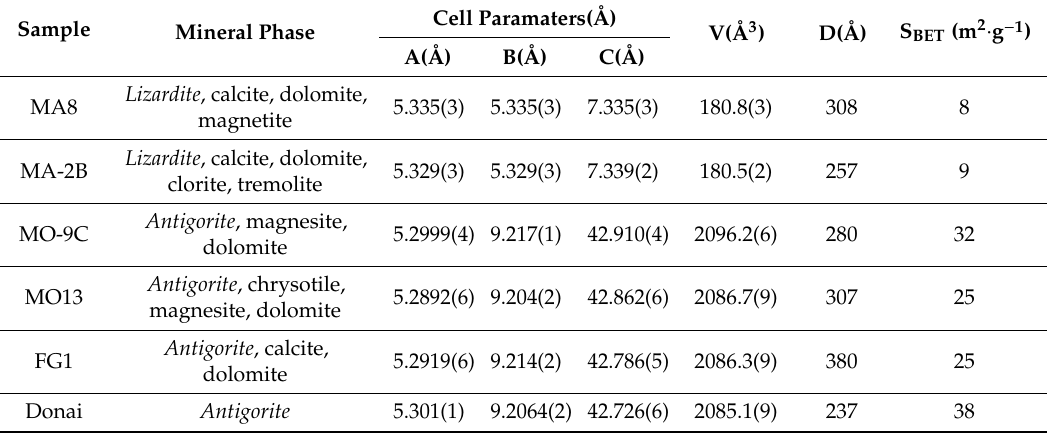
Figure 3. XRD patterns of serpentinites: “ch” chrysotile, “x” Ca(OH) 2 , “c” calcite and “d” dolomite. The position and intensities of the peaks were reported according to the ICDD cards. Table 1. Mineralogic composition, crystallographic data, calculated from the XRD patterns and specific surface area.